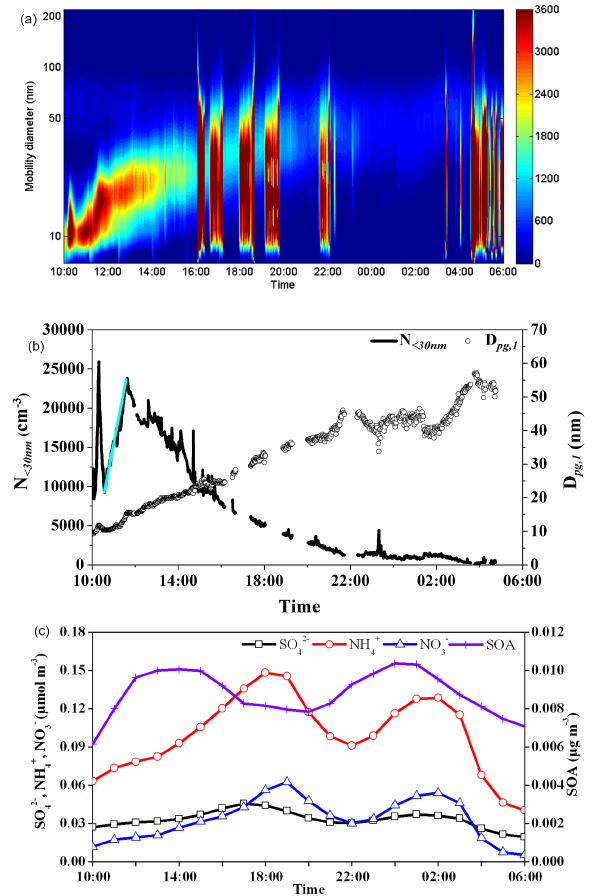
Figure 3. New particle formation on 17 October 2011 ( a particle number concentrations from FMPS (cm − 3 ), b variations of median diameter of particle mode ( D pg , 1 ) and number concentrations of nu- cleation mode particles ( N < 30nm ), (c) CMAQ simulation of SO 2 − NH + , NO − and SOA in PM 2 . 5 ) . 4 3